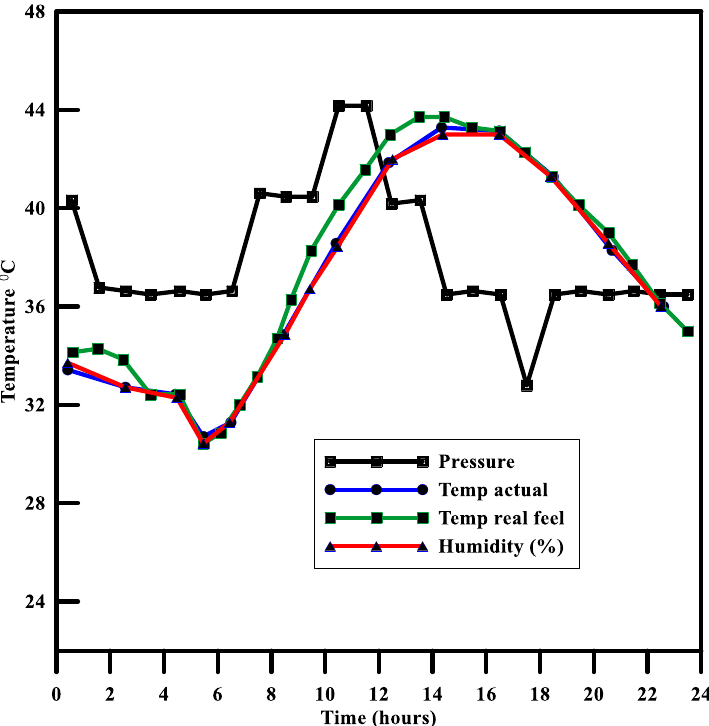
Figure 5. Hourly forecast for real and actual temperature, humidity, and pressure.